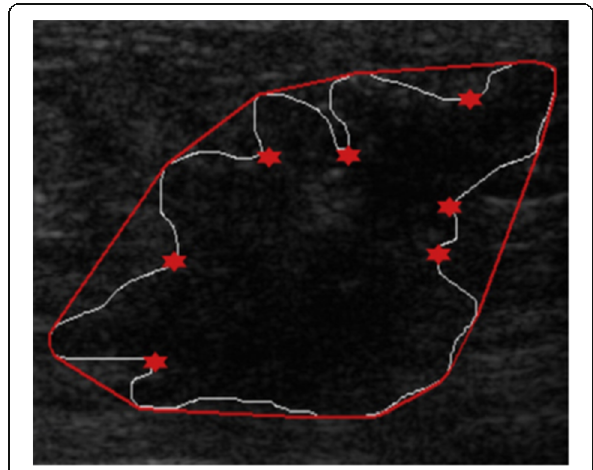
Fig. 3 Convex hull (red contour) of a malignant lesion (white contour), with peaks on the distance vector. V convex are marked by stars